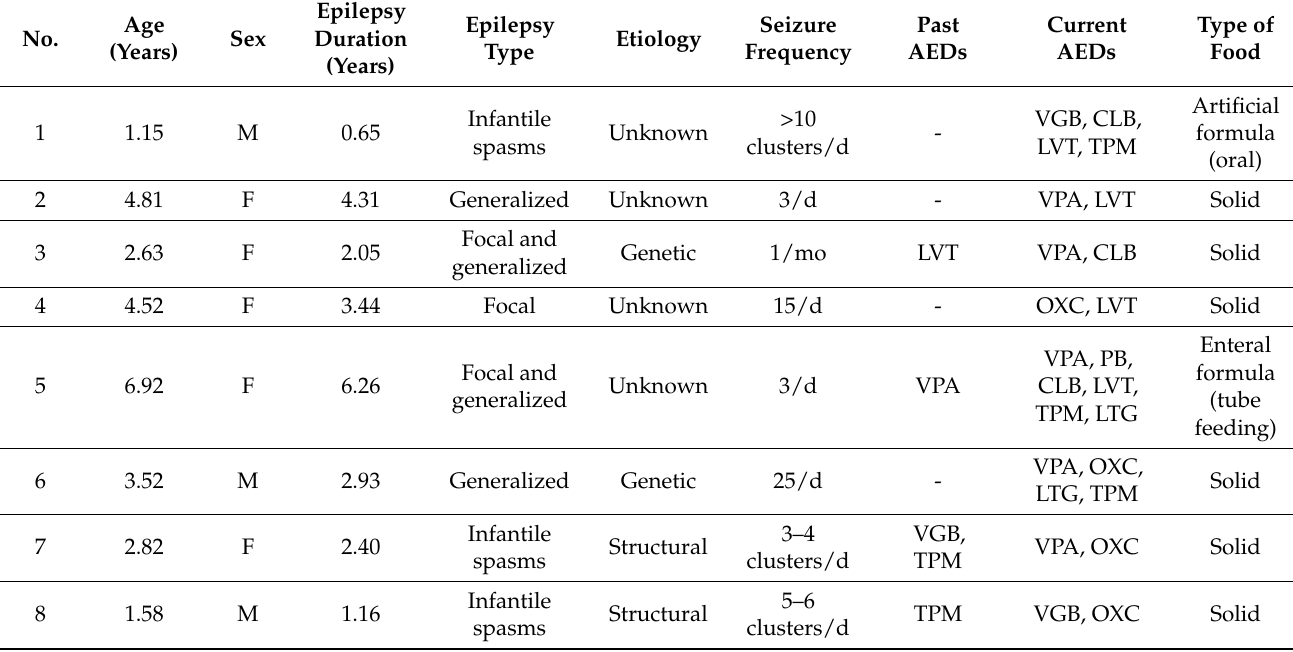
Table 2. Baseline characteristics of the patients with intractable epilepsy.